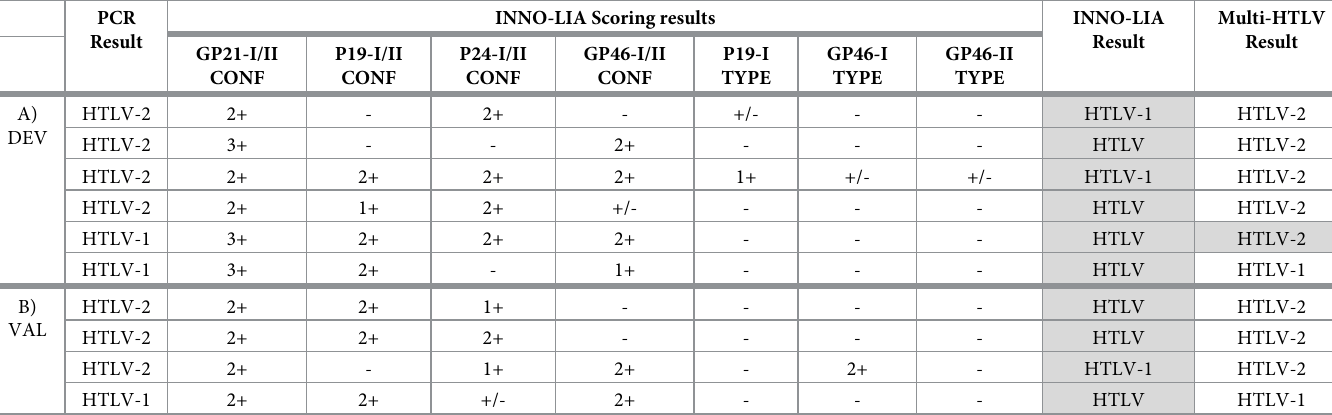
Table 5. INNO-LIA scoring results for untyped and falsely typed samples.